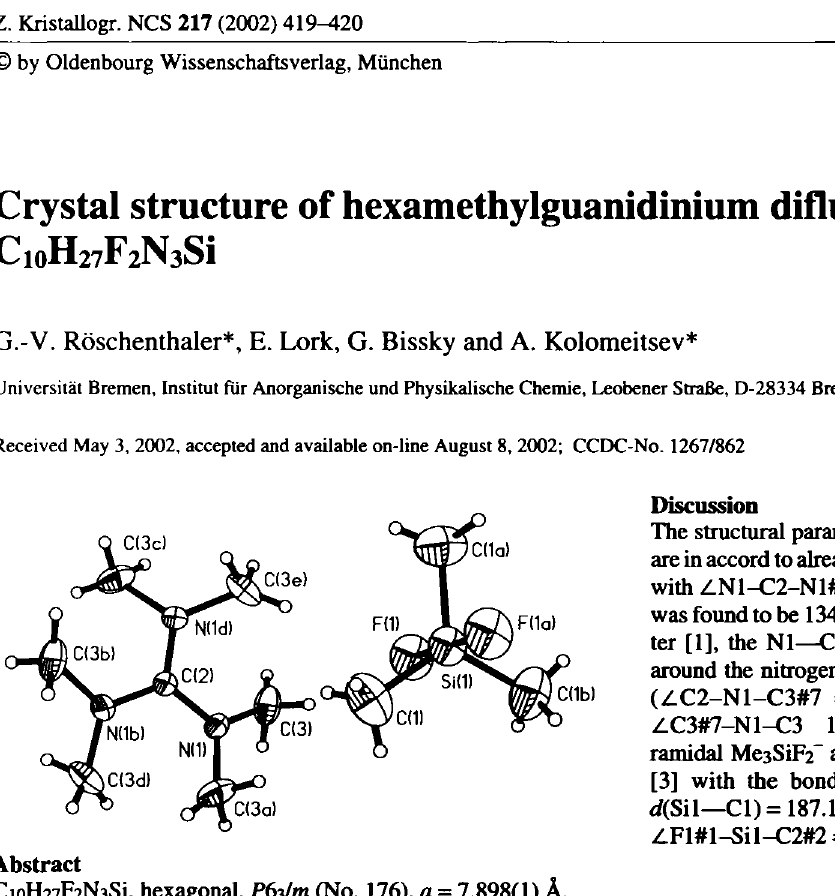
Table 1. Data collection and handling.